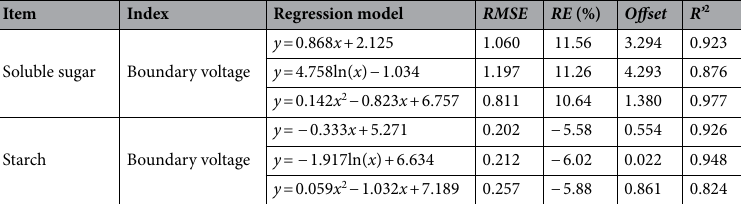
linear, logarithmic, and quadratic regression models for soluble sugar content as a function of reconstructed EIT boundary voltage value, were 0.863, 0.811, and 0.897, respectively ( P < 0.001). Thus, for soluble sugar, the quad- ratic regression model had the greatest R 2 . The R 2 values of the established linear, logarithmic, and quadratic regression models for the starch content as a function of reconstructed EIT boundary voltage value, were 0.894, 0.959, and 0.935, respectively ( P < 0.001). Thus, for starch, the logarithmic regression model had the greatest R 2 . Testing the accuracy of the regression models for soluble sugar and starch contents as func- tions of reconstructed EIT boundary voltage values. The measured data from the cultivar ‘Tender and Soft as Water’ was used to test the accuracy of the regression models. The Root Mean Square Error ( RMSE ), Relative Error ( RE ), Offset , and the coefficient of determination ( R ′ 2 ) of the fitted linear regression based on measured and predicted values were compared between the established linear, logarithmic, and quadratic mod- els. The RE is the percentage of the absolute error of the measurement divided by the measured value. Generally, the RE could well reflect the reliability of a measurement and was calculated using the Eq. (1). RMSE was used to estimate the deviation between the predicted value and the measured value 25 , and was usually used as a standard for assessing the predicted results of a model. The RMSE was calculated using Eq. (2).